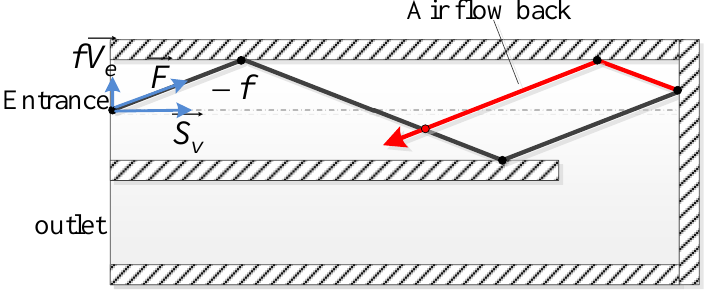
Figure 4. Inappropriate initial airflow direction causes airflow